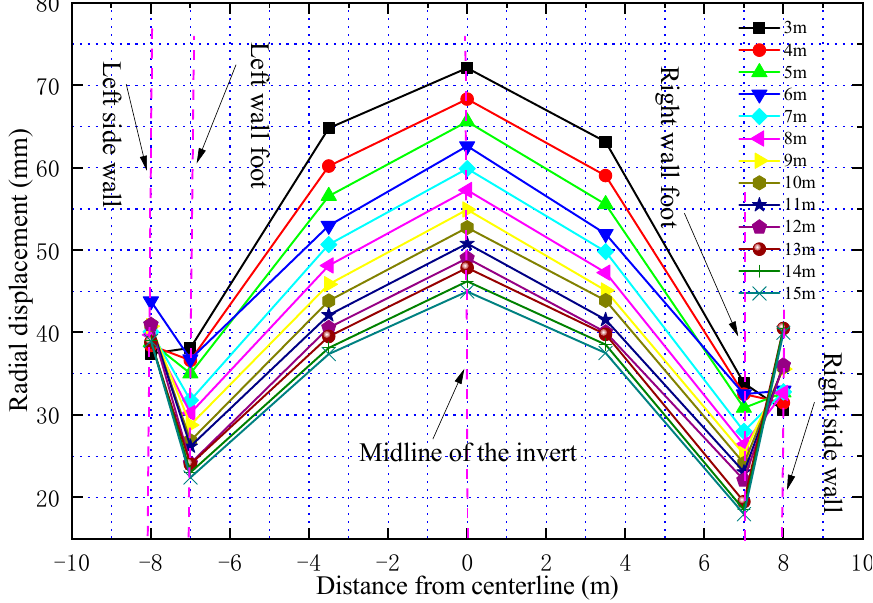
Figure 9. Soil displacement of base and side wall (different pile lengths).